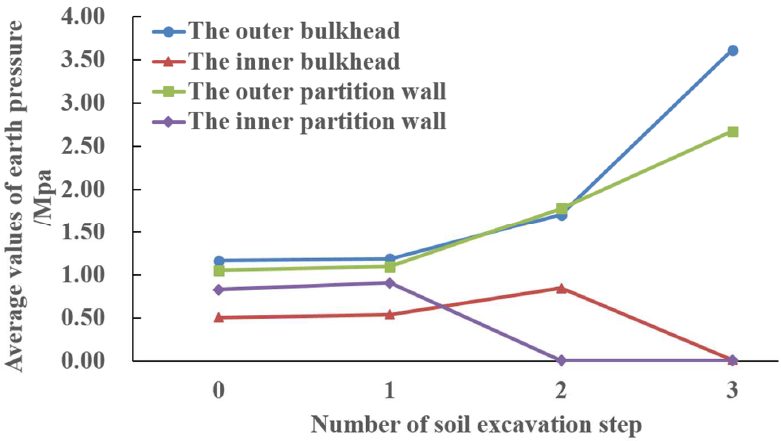
Figure 14. Average earth pressure with soil excavation step by numerical analysis.